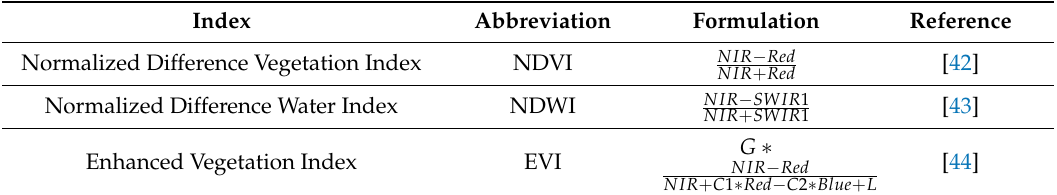
Table 2. Specifications of the used